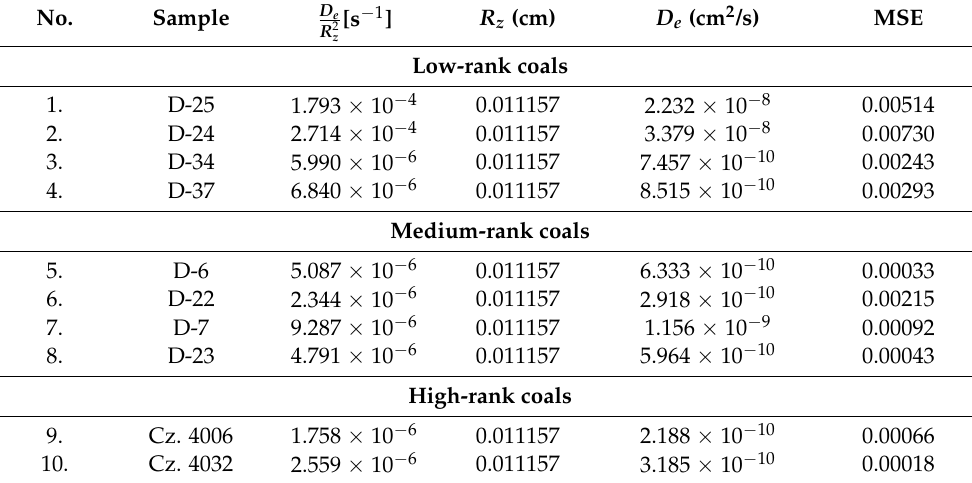
Table 4. The bidisperse diffusion model fitting parameters for the methane adsorption rate data at pressure 0.1 MPa. No.